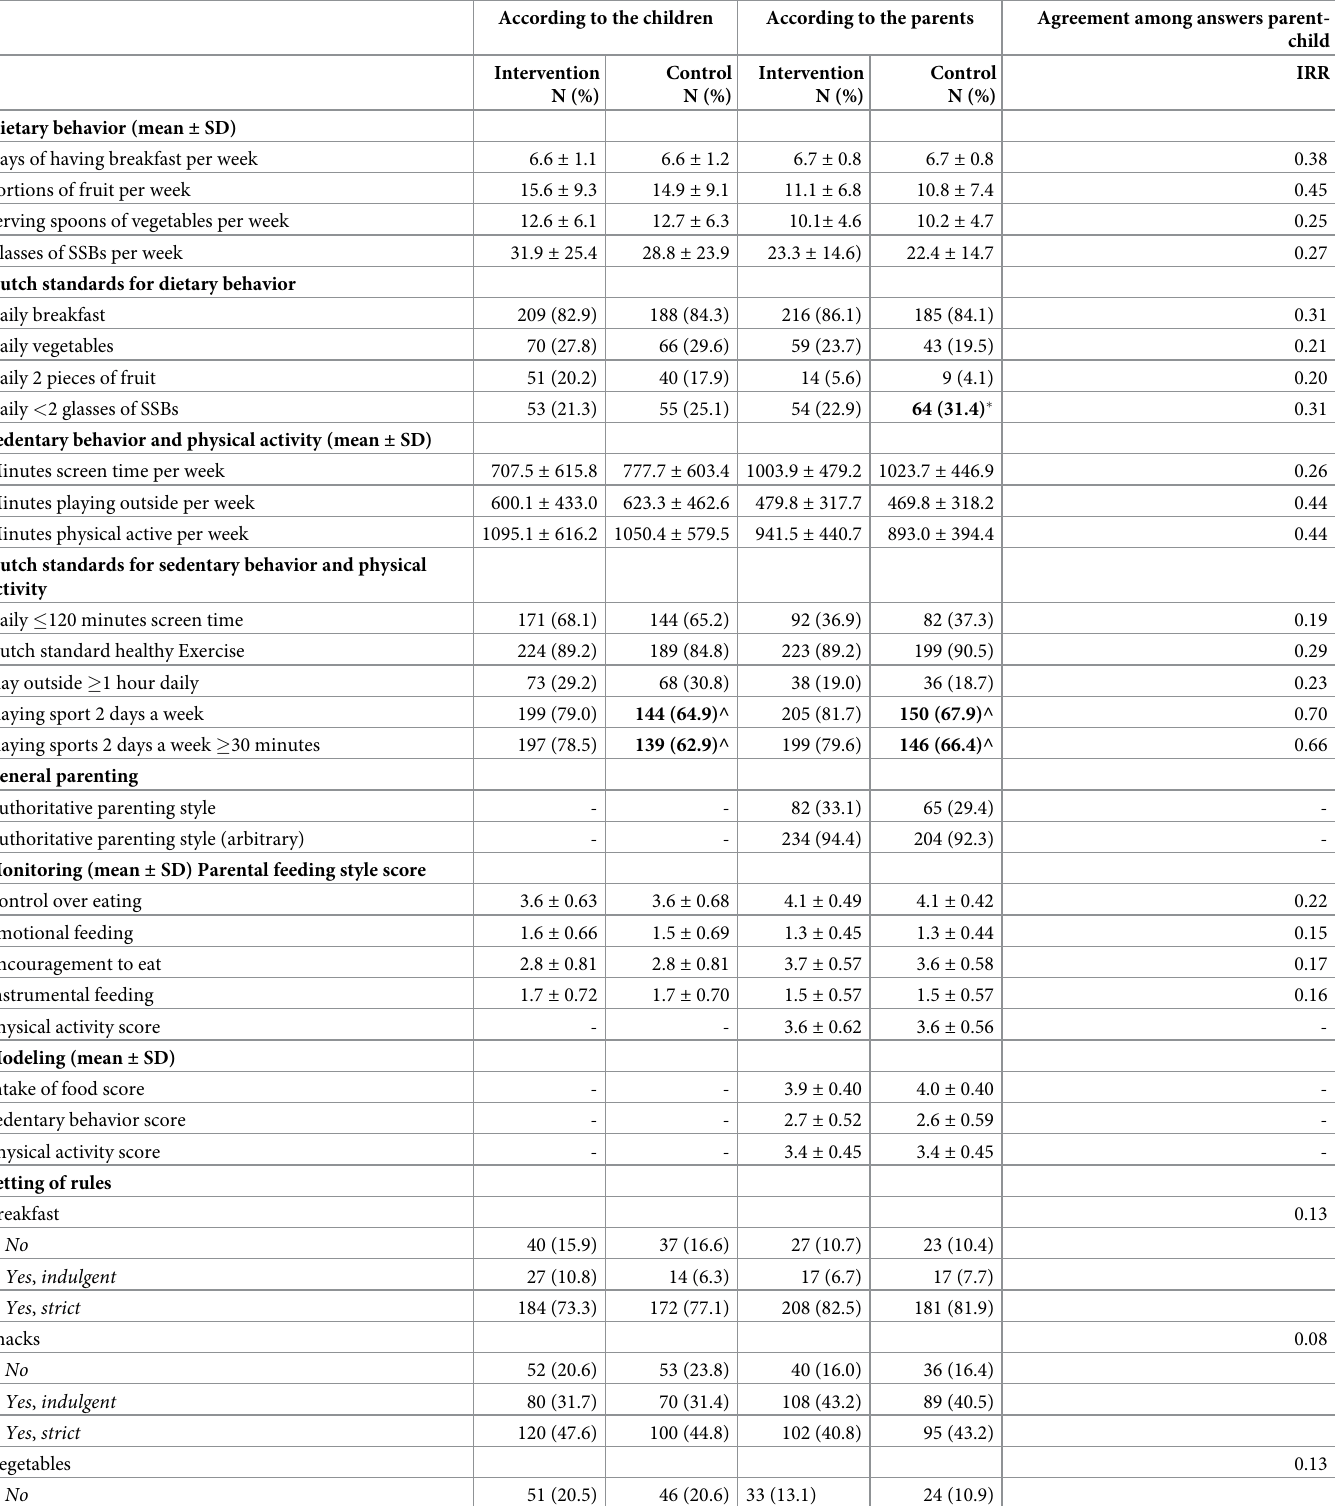
Table 2. Baseline Characteristics of the children’s EBRBs and the parenting dimensions and inter-rater reliability (IRR) within n = 475 parent-child dyads. According to the children According to the parents Agreement among answers parent-